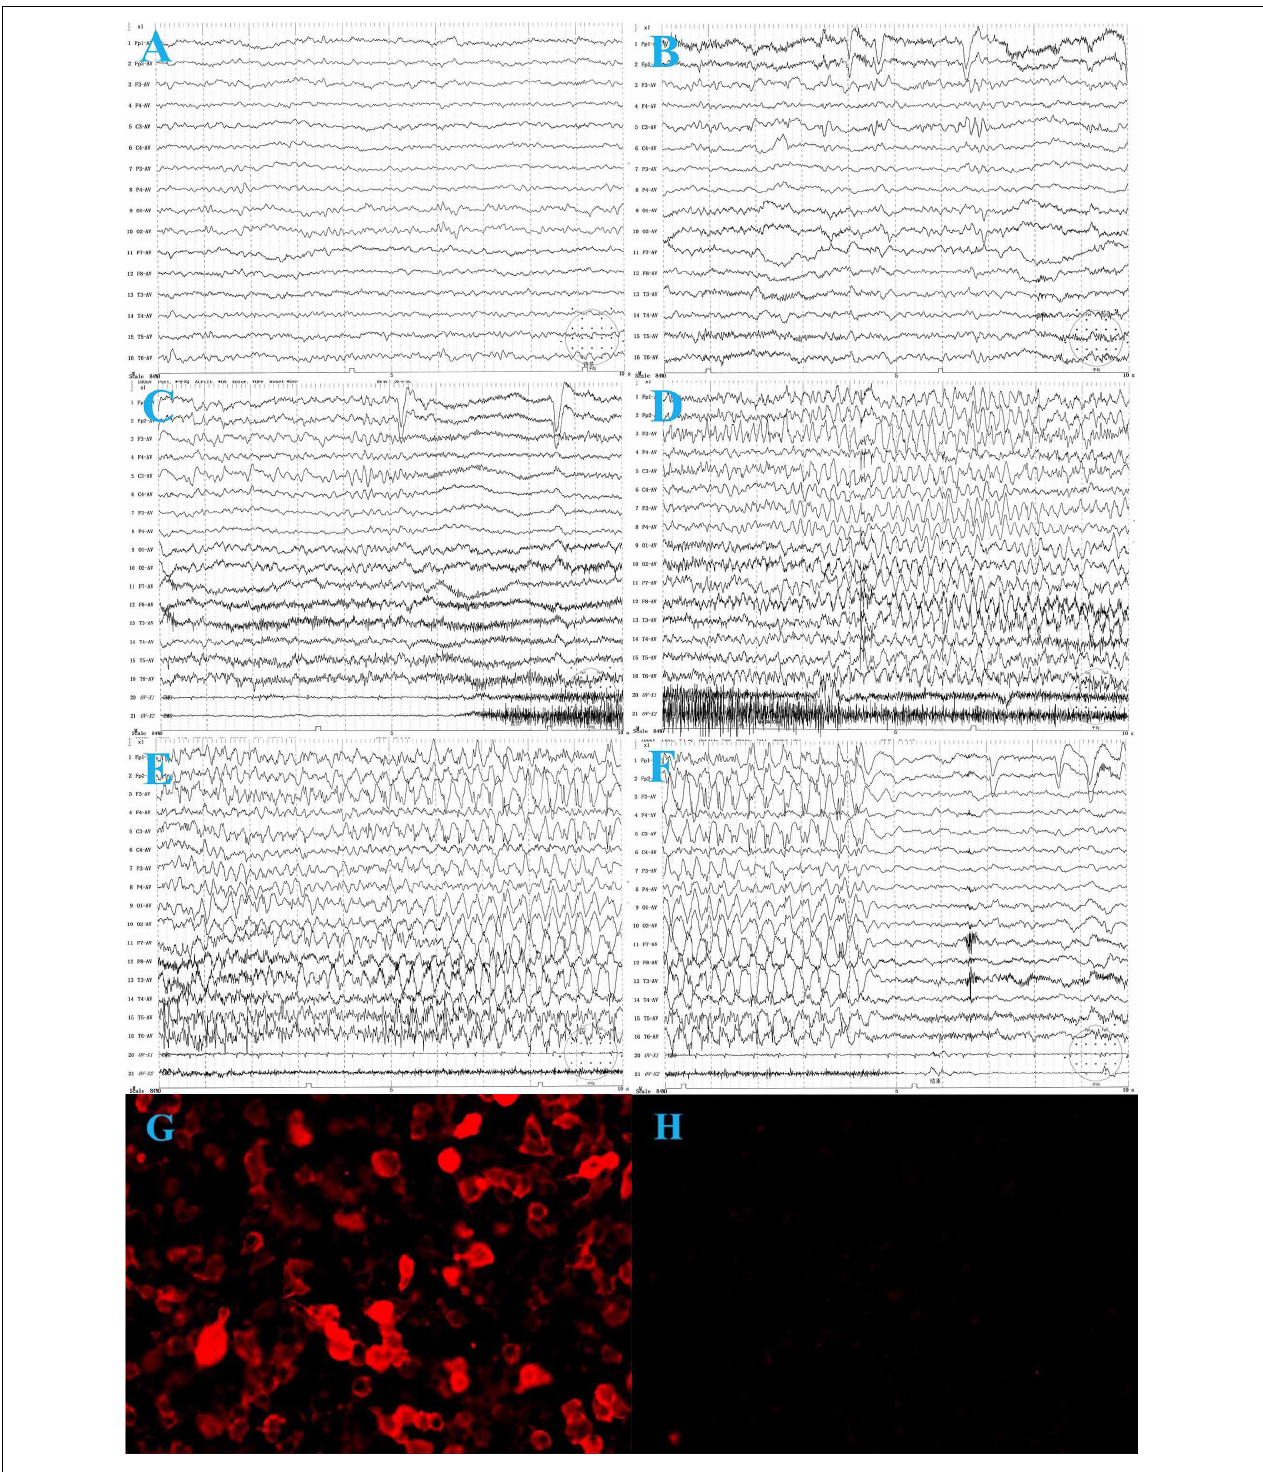
FIGURE 1 | The electroencephalogram (EEG) of the patient before treatment. (A) Background activity: 6 ∼ 7 Hz low to medium voltage theta waves over bilateral occipital regions during wakefulness. (B) Interictal VEEG: spike and slow waves in the left frontal and central regions during wakefulness. (C–F) Ictal EEG: the focal seizure begins with low voltage, fast-wave rhythm over the left frontal and central regions, gradually progressing to spike-and-wave discharges in all regions, predominantly in the left frontal region, lasting about 35 s, during which the electromyography (EMG) burst. The seizure ends and is followed by diffuse background voltage attenuation. (G) Serum anti-LGI 1-Ab: 1:30. (H) One month after treatment, serum anti-LGI 1 Ab is